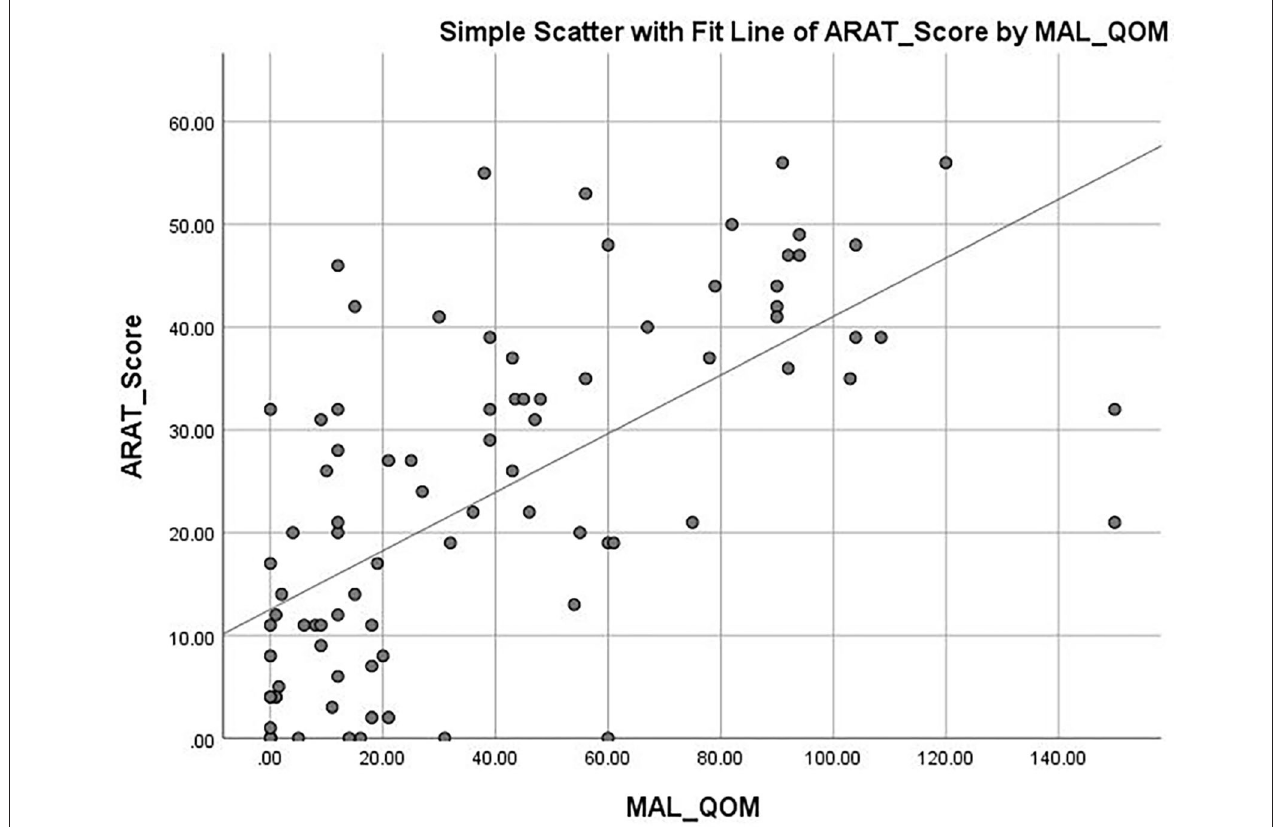
FIGURE 3 | The correlation between ARAT score and MAL-QOM